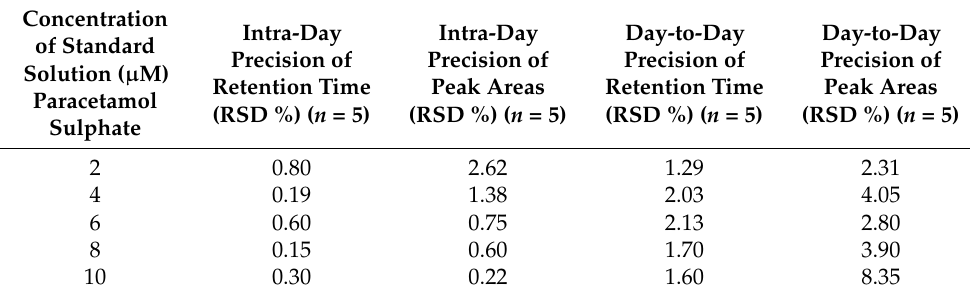
Table A3. Within-day and day-to-day precision of retention time and peak areas of paracetamol sulphate standard solutions in drug-free intestinal perfusate.